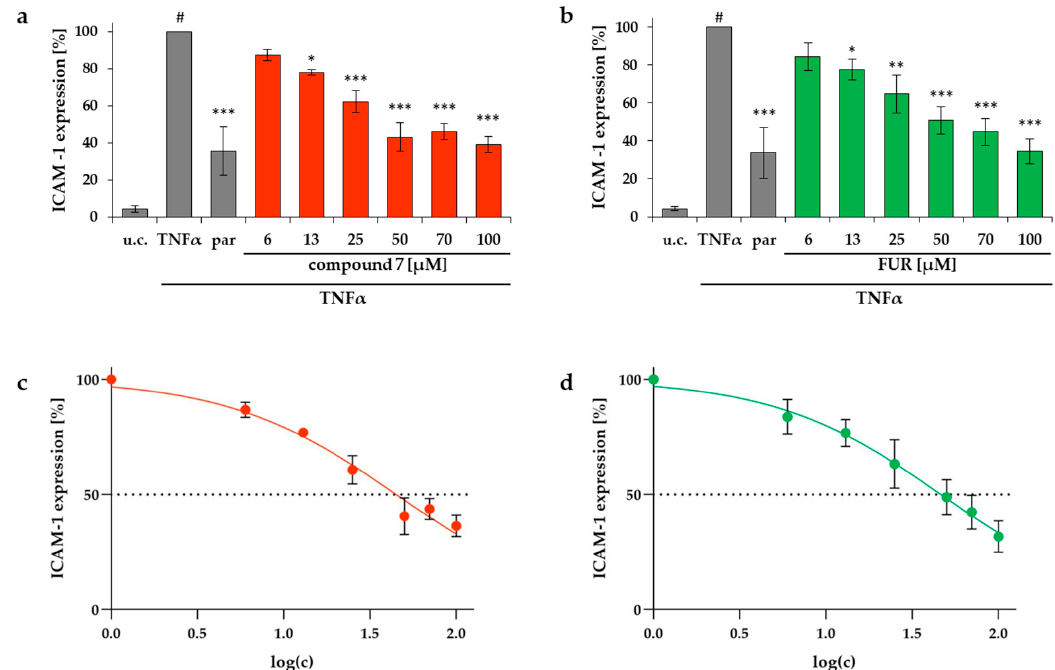
Figure 9. Influence of compound 7 ( a , c ) and FUR ( b , d ) on ICAM-1 expression in HMEC-1 cells. The test was performed with pure medium (u.c.), with TNF α (10 ng/mL) and parthenolide + TNF α (par, 5 µ M) as positive control. Substance concentrations between 6–100 µ M were applied. Data are presented as mean ± SD ( a , b ) and nonlinear regression curve ( c , d ); # p < 0.001 vs. u.c.; * p < 0.05, ** p < 0.01, *** p < 0.001 vs. TNF α ( n =